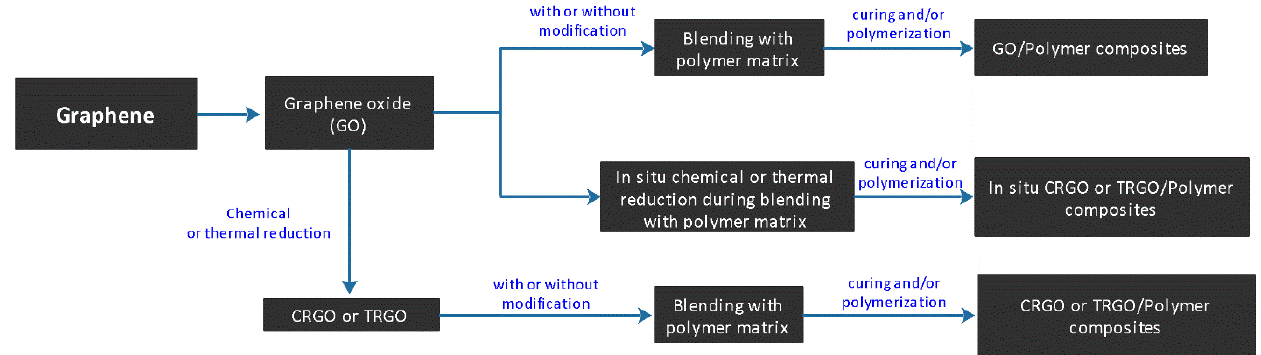
Figure 6. The general fabrication routes for polymer-based composites with GO or RGO as fillers; Reprinted with permission from [101].